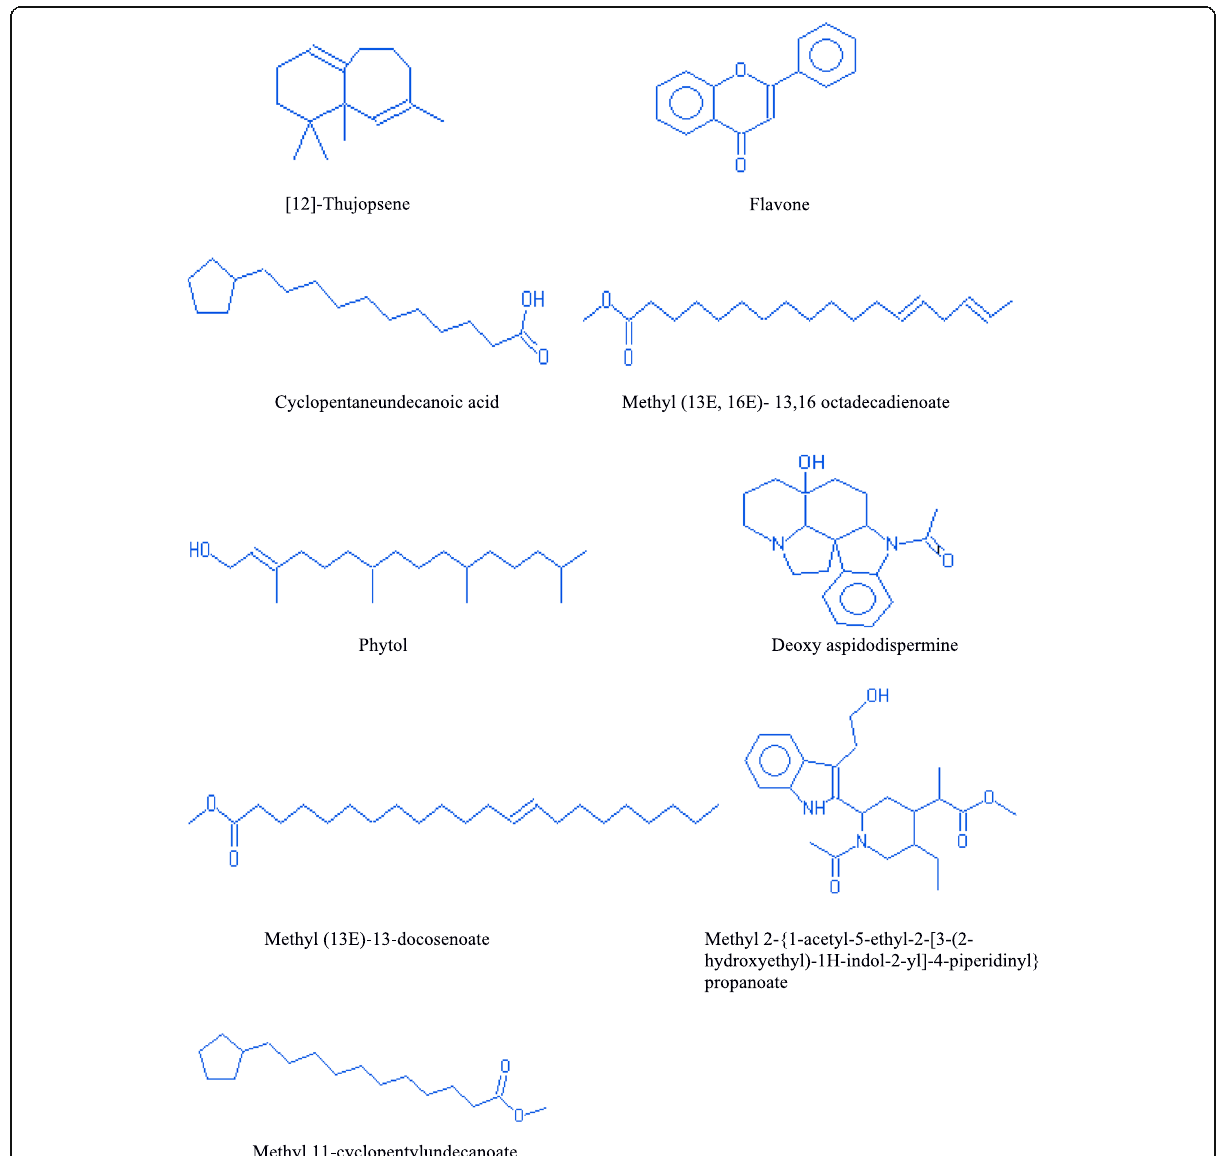
Fig. 8 Structures of phytochemicals detected in the methanolic extract of naturally grown L.